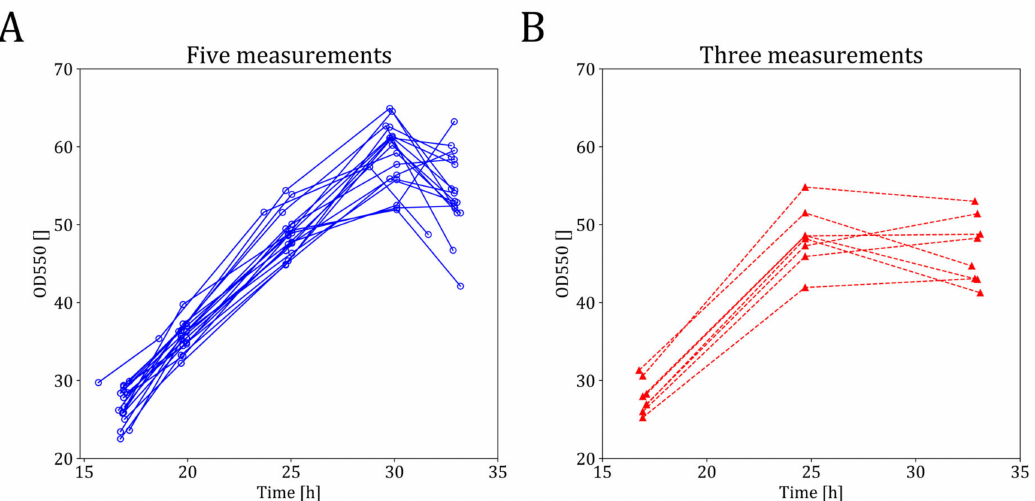
Figure 4. Comparison of OD trends of fermentations with identical process conditions with five OD measurements ( A ) and fermentations with three OD measurements ( B ) of strain